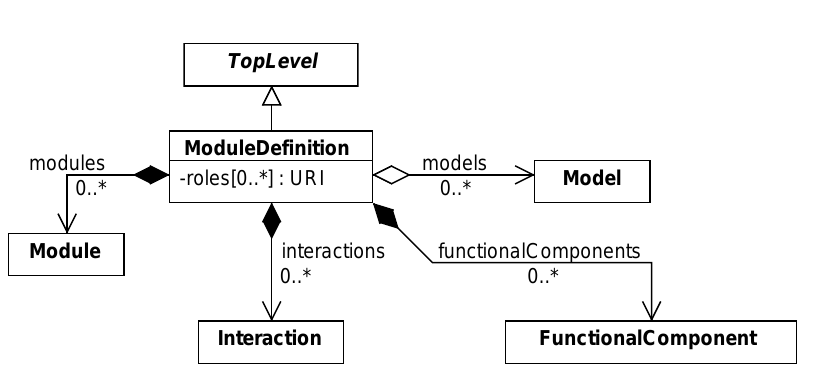
Figure 15: Diagram of the ModuleDefinition class and its associated